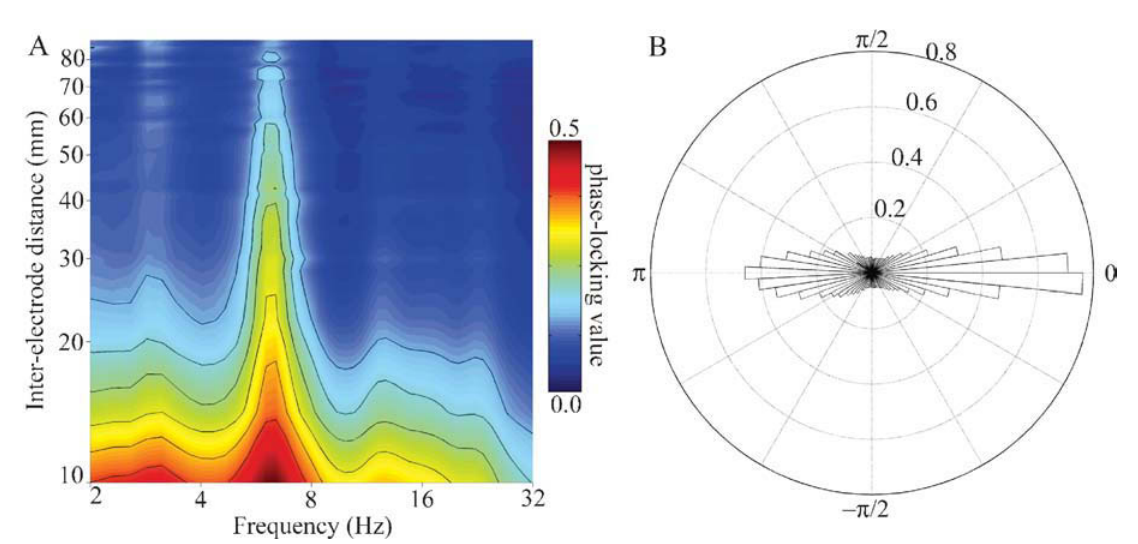
Figure 8. (A) Mean PLV as a function of frequency and inter-electrode distance for all pairs of electrodes in subject A. Larger PLVs indicate that pairs of electrodes exhibit a greater degree of phase coherence at that frequency. Note that for all inter-electrode distances the strongest phase coherence occurs in the theta (4–8Hz) band, with smaller peaks occurring in the delta (2–4Hz), alpha (8–12Hz), and beta (12–30Hz) bands. Outermost contour line indicates a PLV of 0.15; other contours indicate steps of 0.05. ( B ) Normalized polar histogram of preferred phase differences between electrode pairs for all frequencies and inter-electrode distances in subject A . Note that phase differences are clustered around 0 degree (in phase) and 180 degree (out of phase). This has implications for the ease of communication between areas (see Discussion). 192